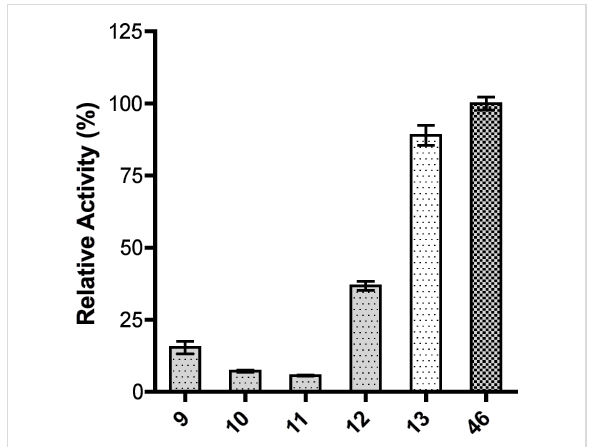
Figure 5: Comparison of the relative activity of synthetic Man p -1P analogues 9 – 13 for GDP-ManPP, with that of the parent compound 46 . Error bars represent the standard deviation of duplicate reactions.